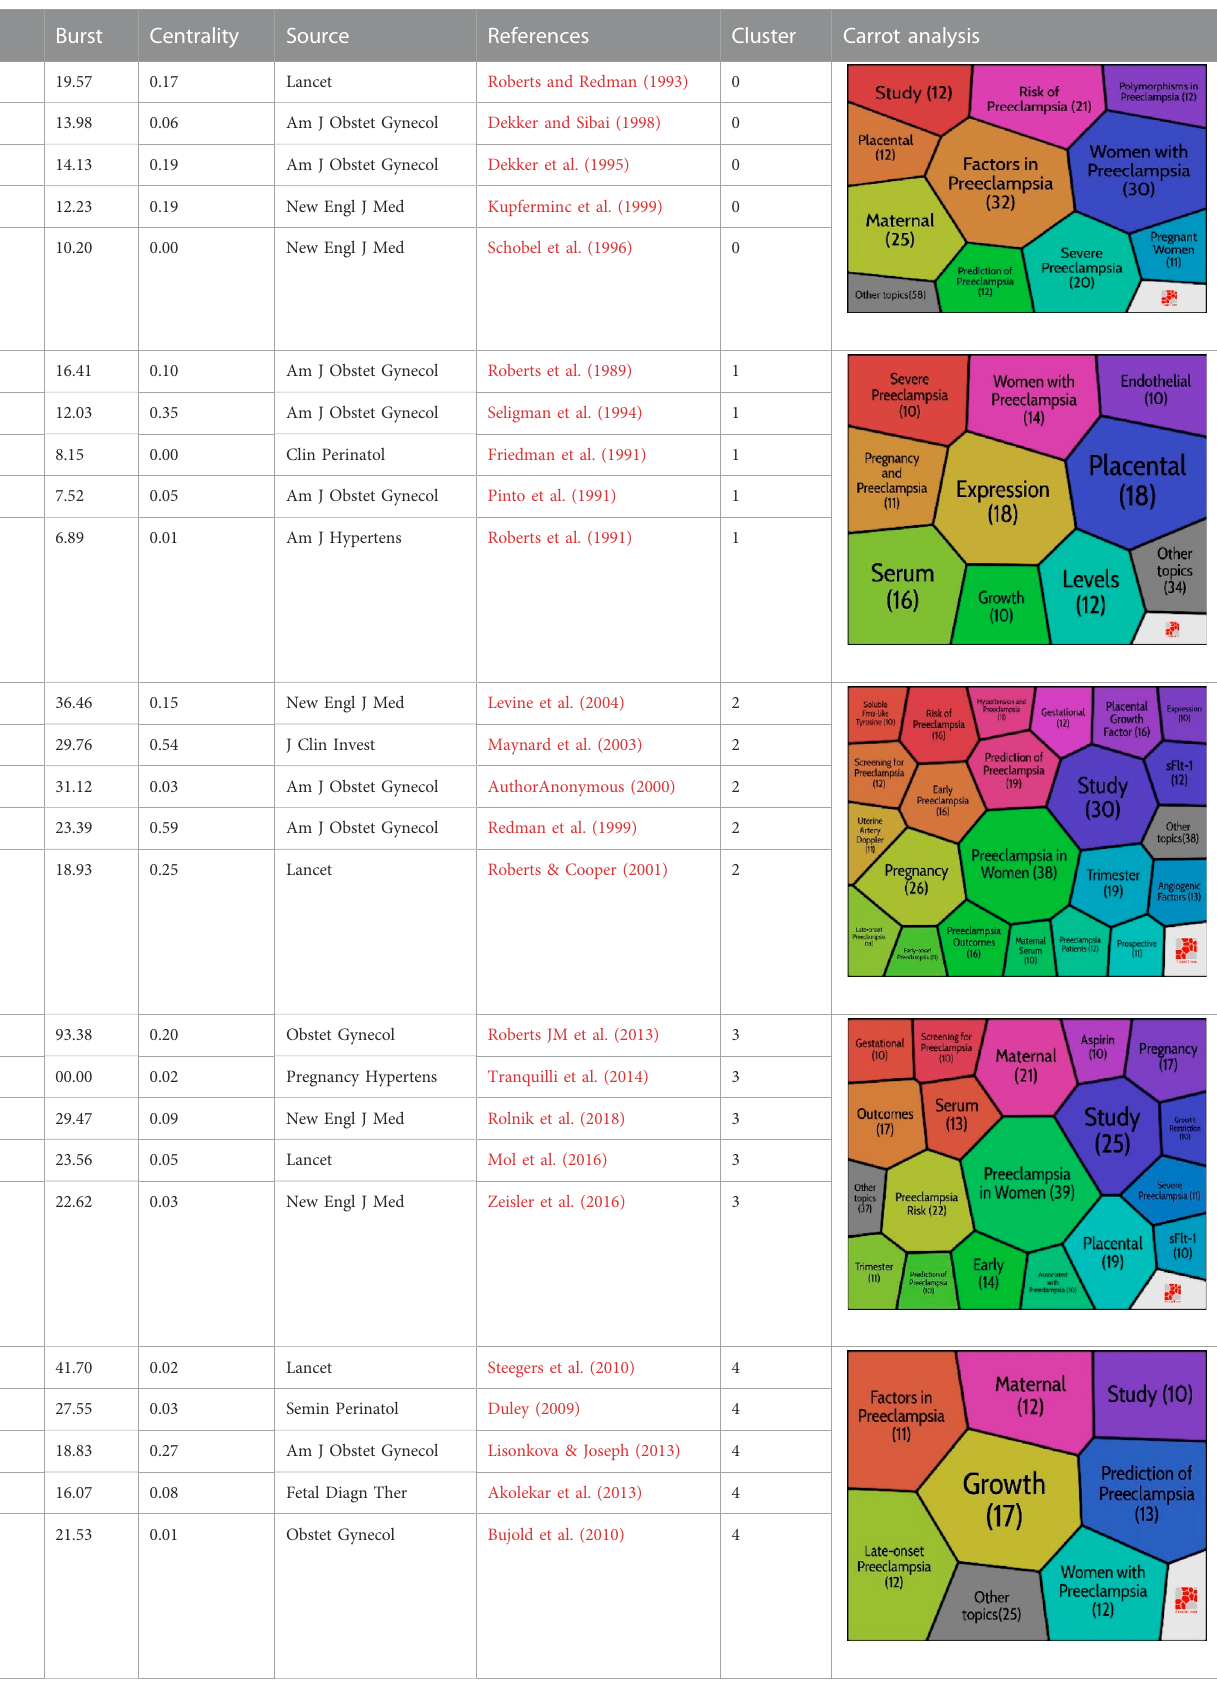
TABLE 5 The fi rst fi ve authors contribute to selected